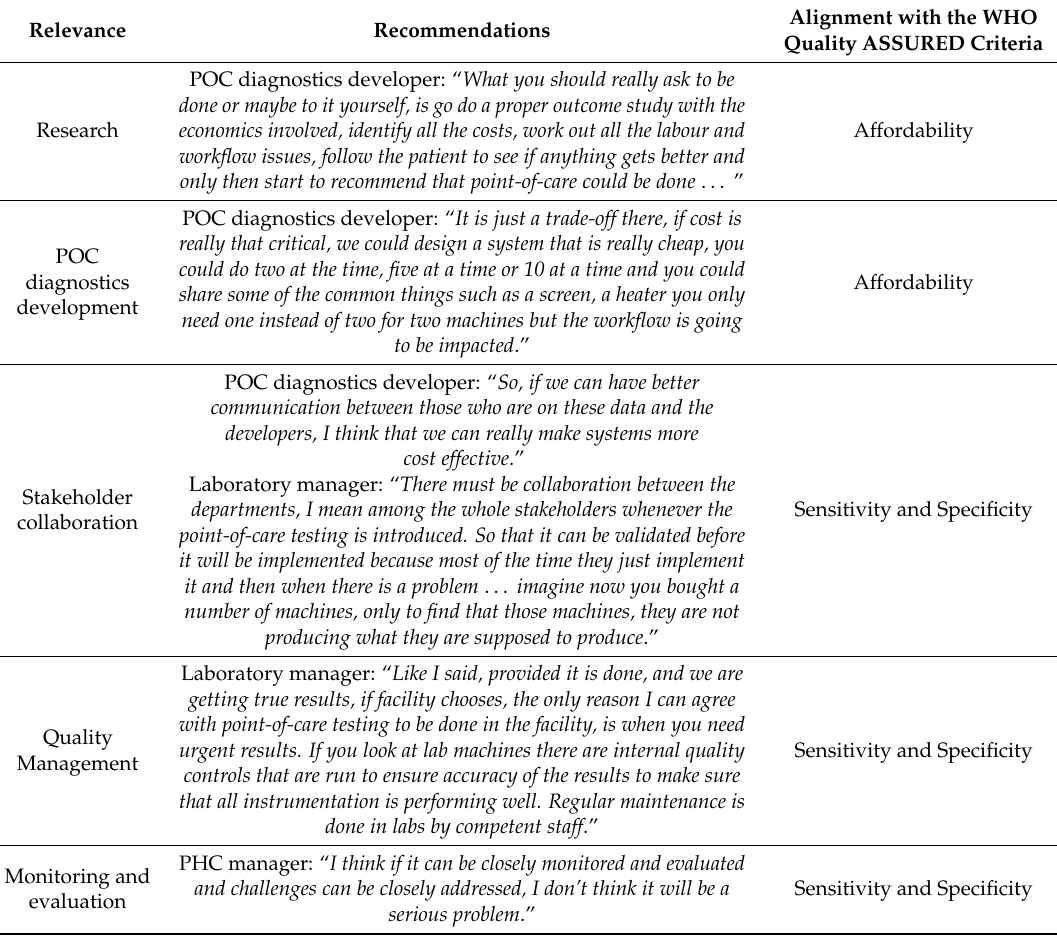
Table 3. Stakeholders’ recommendations for improving the effectiveness of POC diagnostic services in rural PHC